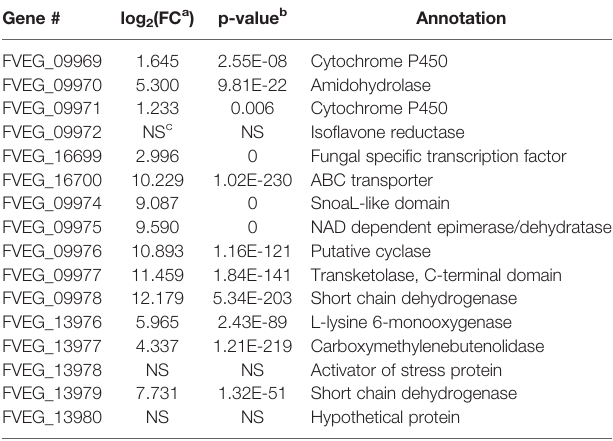
TABLE 4 | Gene clusters with differential expression upon exposure to chlorzoxazone